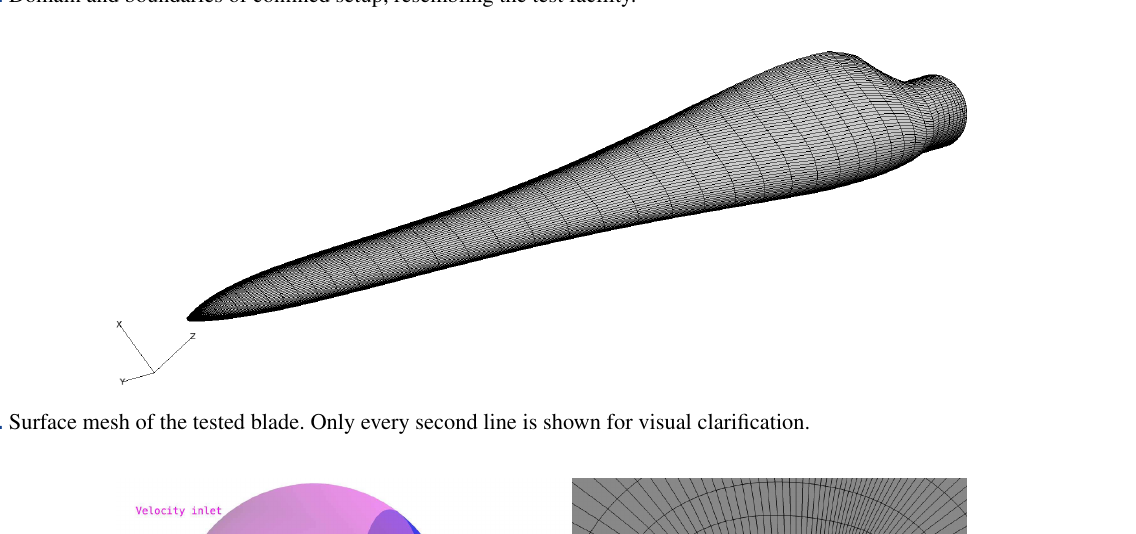
Figure 3. Domain and boundaries of confined setup, resembling the test facility.